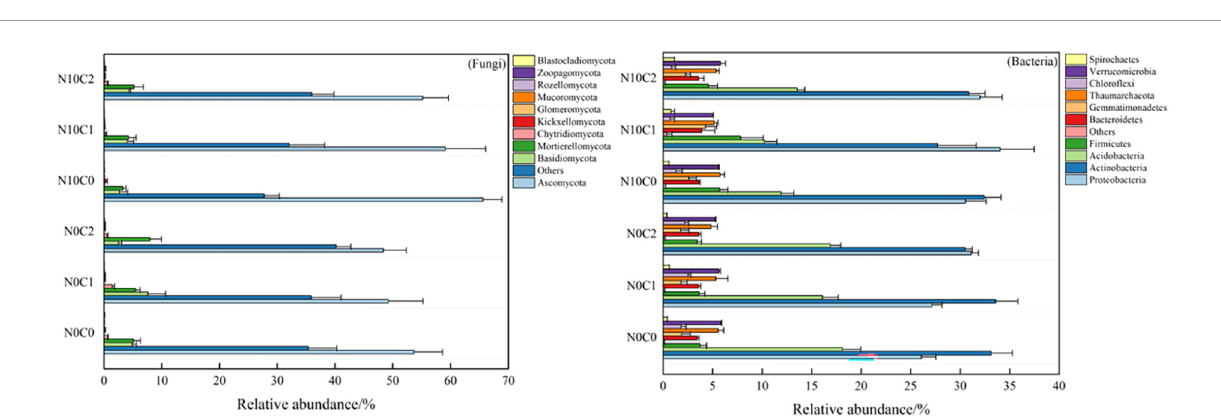
plants with divergent N utilization (Gherardi et al., 2013) and experimental duration (De Schrijver et al.,